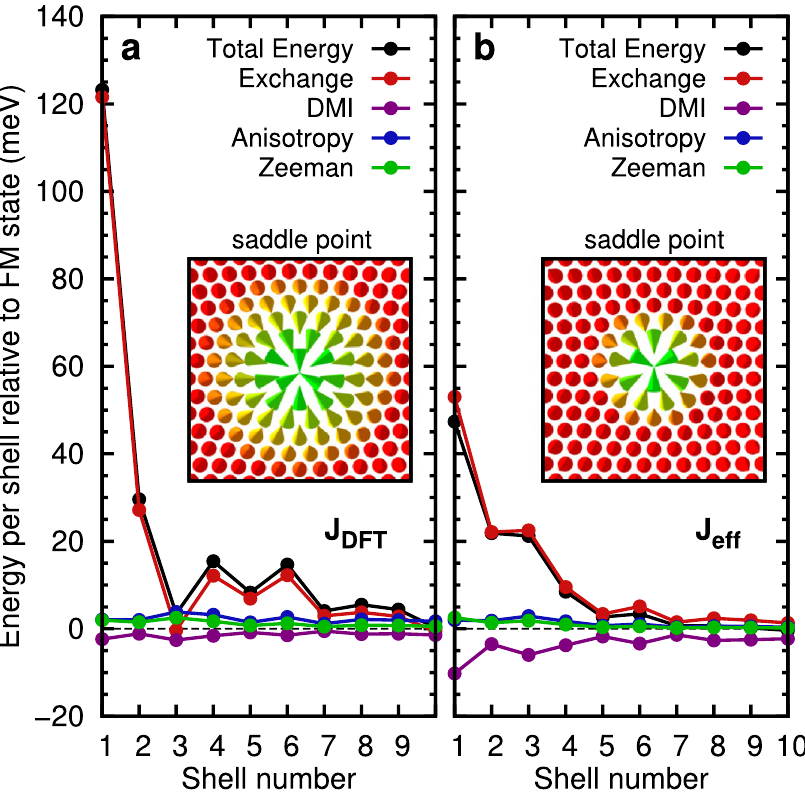
Figure 4. Energy contributions at the saddle point. Total energy per shell and contributions of the individual interactions are shown relative to the FM state for fcc-Pd/Fe/Ir(111) over the lattice shells of the saddle point for